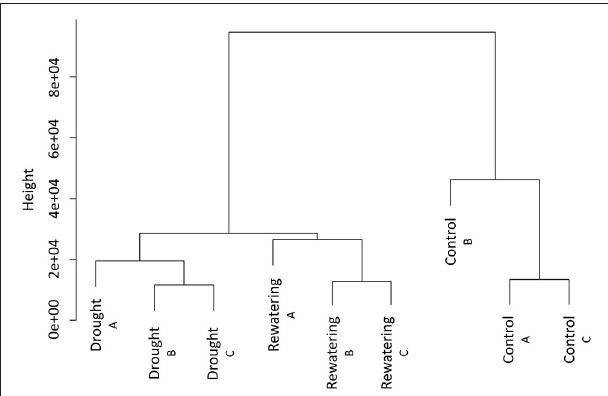
FIGURE 2 | Hierarchical clustering of MSAP-Seq data of three samples (control, drought, and re-watering) performed in three independent biological